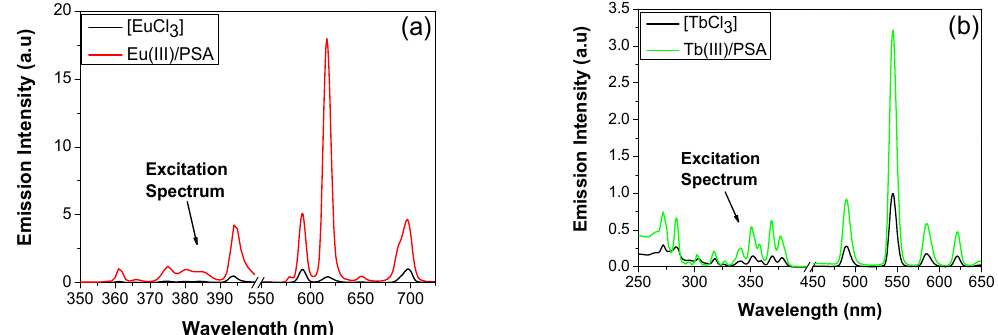
Figure 1. Excitation spectra (left side) and emission spectra (right side) of ( a ) EuCl 3 and Eu 3 + / PSA ( λ em = 616 nm and λ ex = 395 nm) and ( b ) TbCl 3 and Tb 3 + / PSA ( λ em = 545 nm and λ ex = 273 nm) in aqueous solutions at pH 7.2.